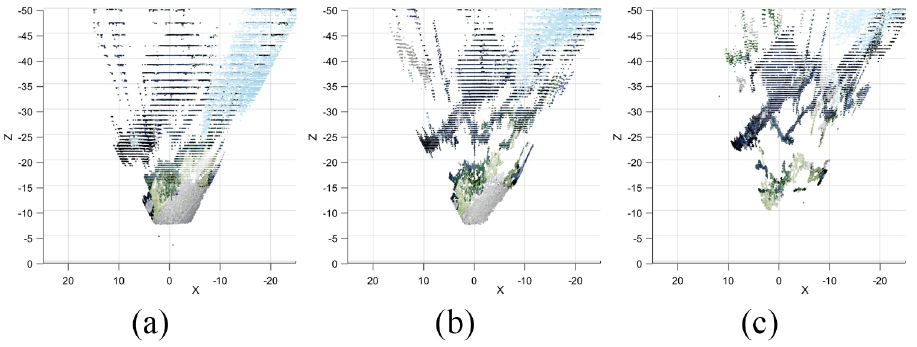
Figure 16. Point cloud from depth estimation of ( a ) baseline 1.0 m, ( b ) baseline 2.0 m, and ( c ) baseline 3.0 m seen from top–down view.